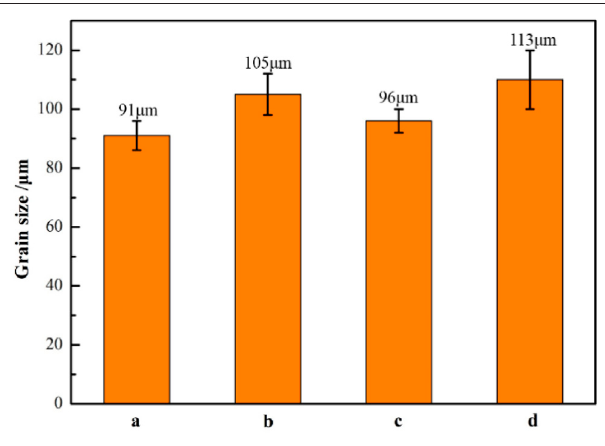
FIGURE 6 | The grain sizes of block a, block b, block c, and block